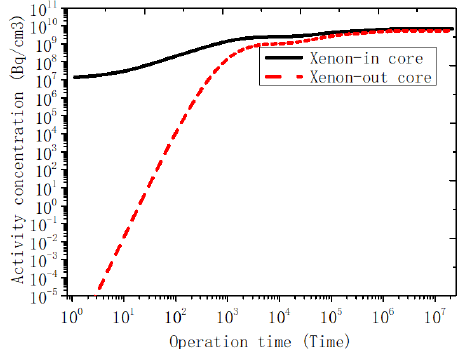
Figure 2. Reactor core model(Side view) Table 1. Overall design parameters of 2MW MSR